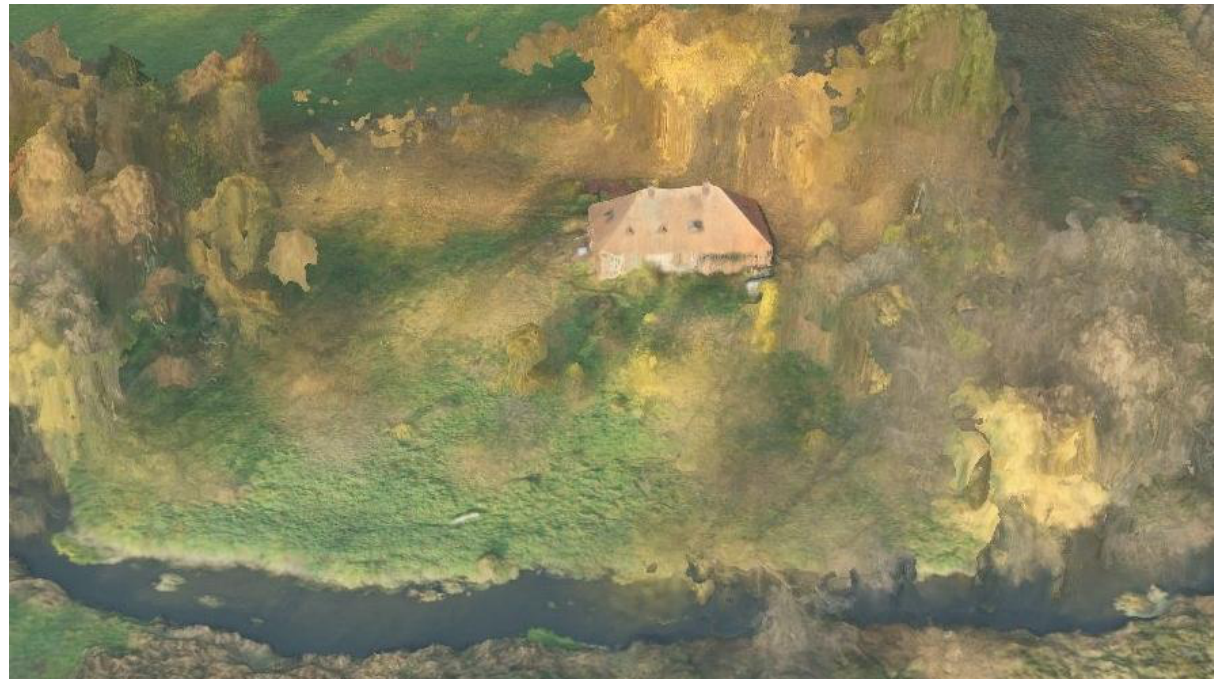
Figure. 7 The 3D model of Manor house and its